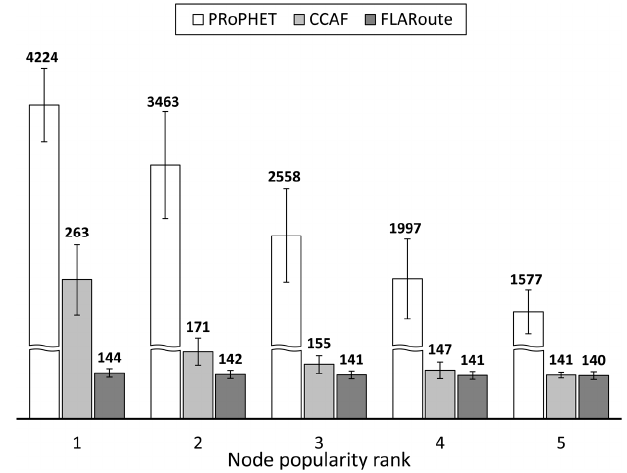
Figure 28. Energy consumption (in Joules) on the five most popular nodes.